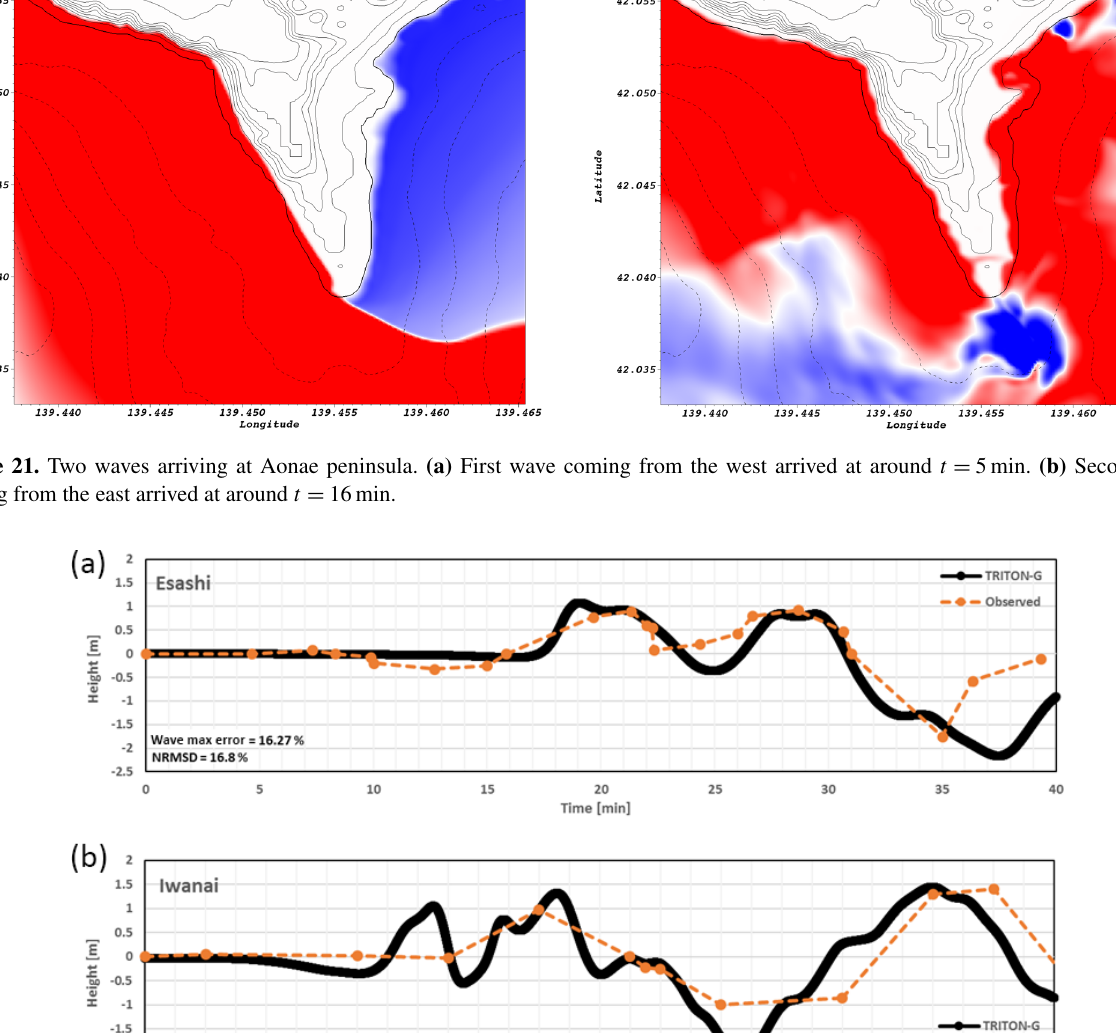
Two waves arriving at